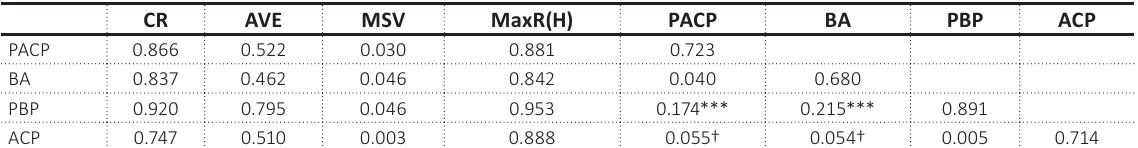
Table 2. Validity